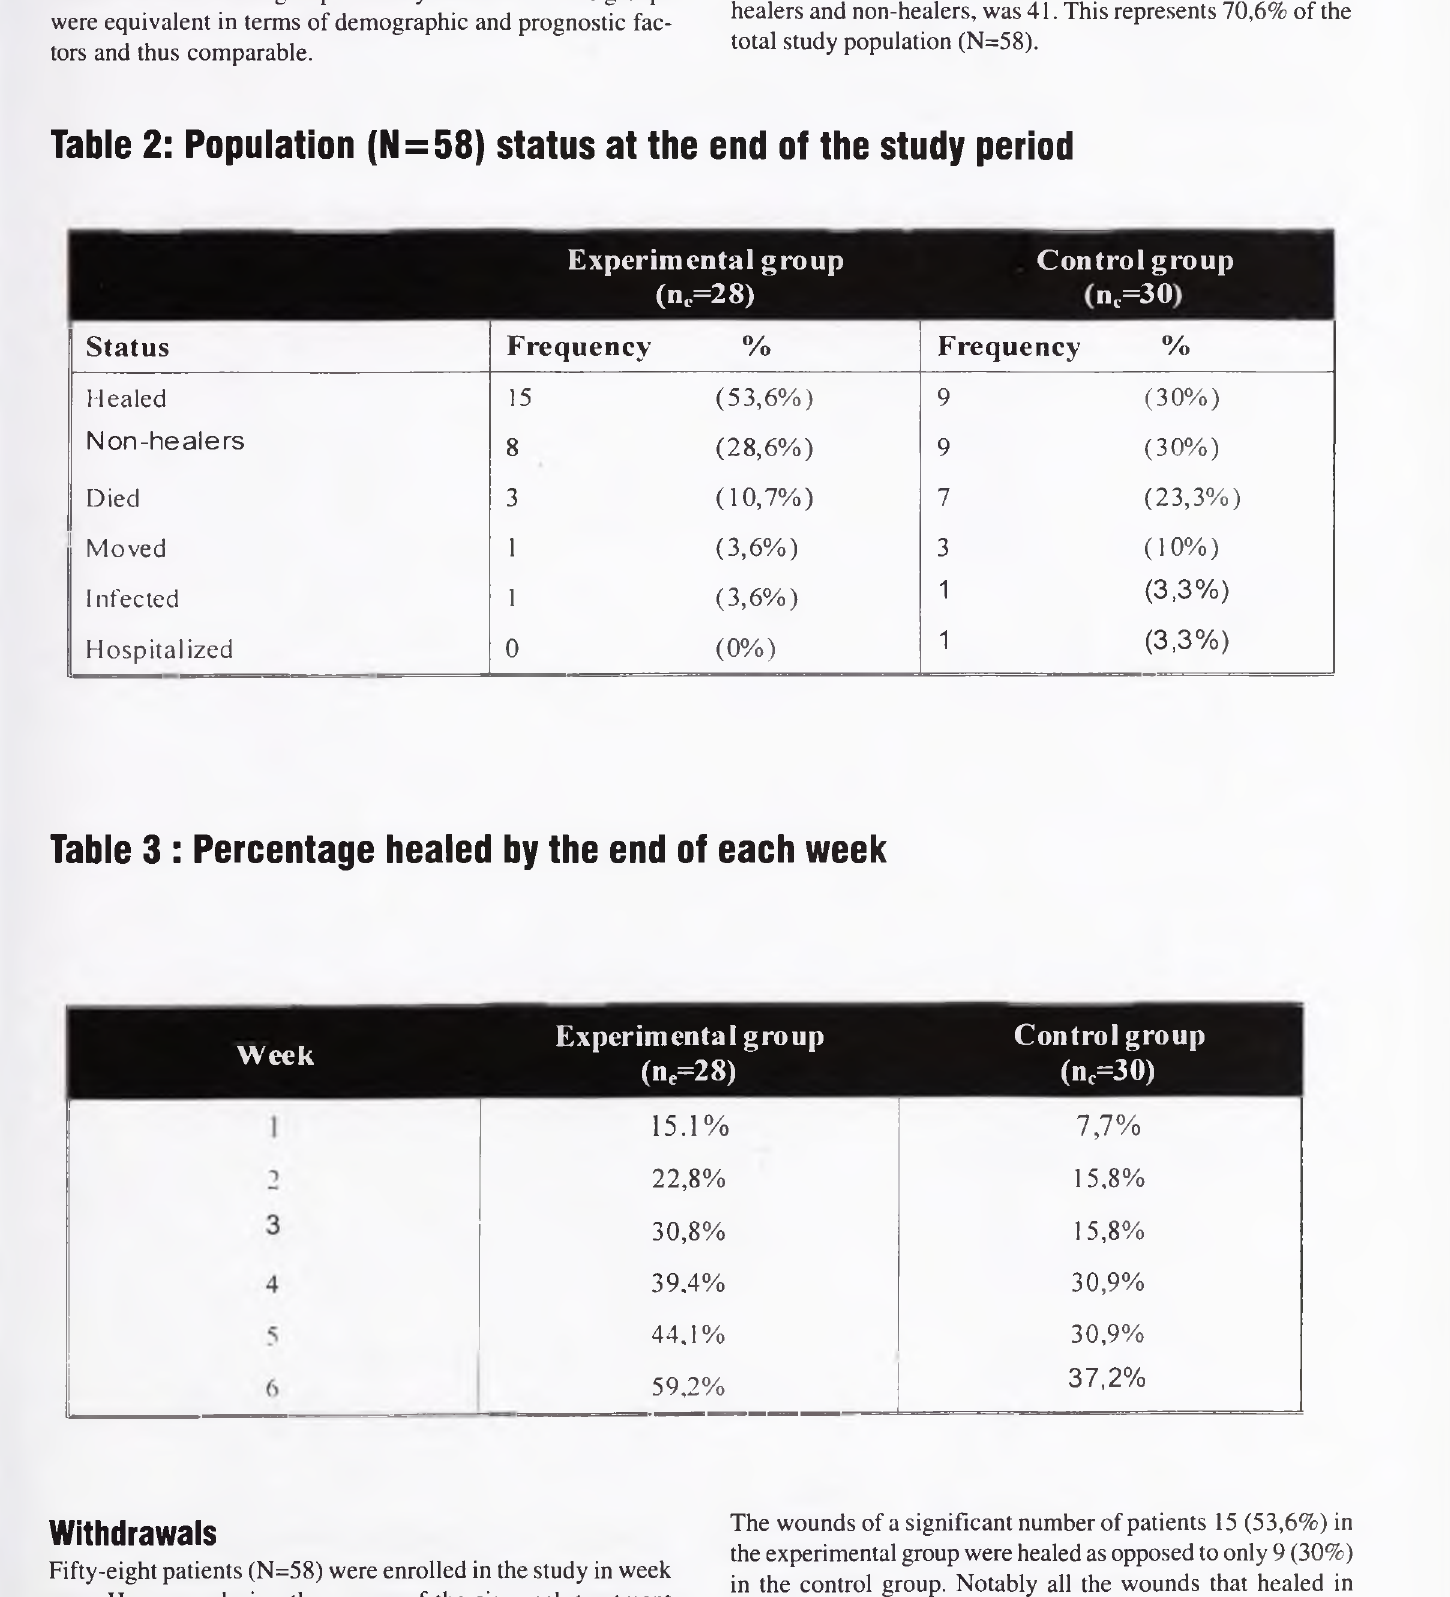
Experimental group